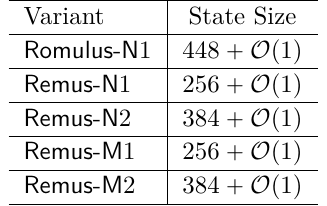
Figure 19: Serial state update function used in Romulus and Remus . Table 9: Practical state size of Romulus and Remus